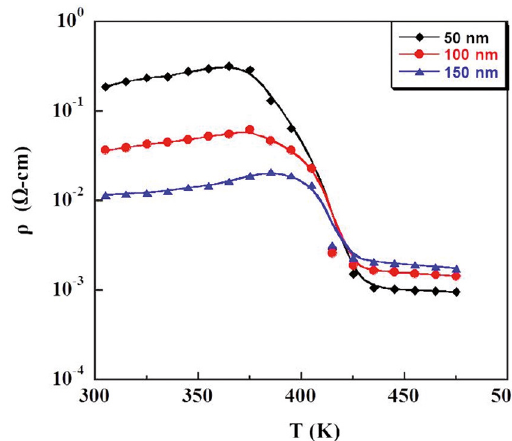
Figure 3: Temperature dependence of the resistivity (ρ) as a function of temperature (T) of V: In O thin films with different thicknesses. 2 3 and V O , which acts as a carrier traps rather than electron 2 5 donors. As observed from Figure 3, the resistivity for all films increases with increasing the temperature up to